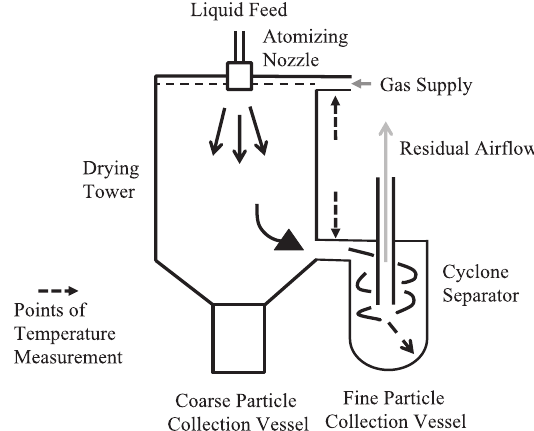
Fig. 2 Schematic of a spray drier illustrating the key elements of solution feed, gas supply, temperature control and monitoring and collection vessels before and after the size selective cyclone separator.